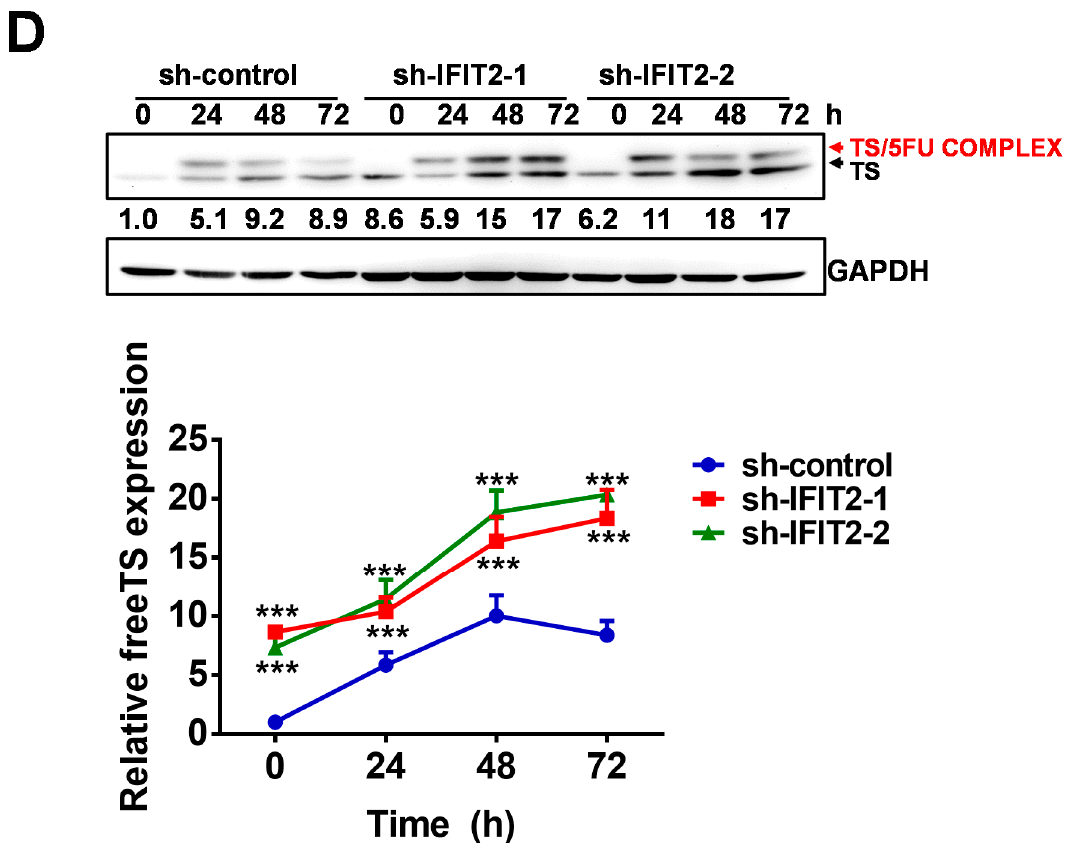
Figure 4. Protein and mRNA levels of 5-FU metabolic enzymes. ( A ) Protein levels. The whole cell lysates of sh-control, sh-IFIT2-1 and sh-IFIT2-1 cells were immunoblotted for TS, TK1, OPRT and TP. Bar graph indicates quantitative densitometry of Western blot analysis of three independent experiments relative to sh-control. The symbols ** and *** denote statistically significant differences compared to sh-control at p < 0.01 and p < 0.001, respectively. ( B ) mRNA levels. The relative mRNA expression levels of 5-FU metabolic enzymes in sh-control, sh-FIT2-1 and sh-IFIT2-2 cells were determined by Q-PCR. GAPDH mRNA was used as an internal control. * p < 0.05, ** p < 0.01 denotes a statistically significant difference compared to sh-control. ( C ) Immunostaining. The intracellular distribution of TS in sh-control, sh-FIT2-1 and sh-IFIT2-2 cells with or without 5-FU treatment (10 µM for 48 h) was determined by immunostaining (red). The nuclei were counterstained with DAPI (blue). Quantitative analysis of the mean fluorescence intensity is shown in bar graph. The symbols ** and *** denote statistically significant differences compared to non-treated sh-control at p < 0.01 and p < 0.001, respectively. ( D ) Formation of the TS/5-FU complex. As described above, the cells were treated with 10 µM 5-FU for various time periods. The upper band (red arrow) denotes the TS/5-FU complex, and the lower band (black arrow) represents free TS. GAPDH was used as a loading control. The numbers represent the relative expression level of Free TS protein in compared to control cells. Quantitative densitometry of Western blot analysis of three independent experiments. *** p < 0.001 denotes a statistically significant difference compared to sh-control at 0 h.